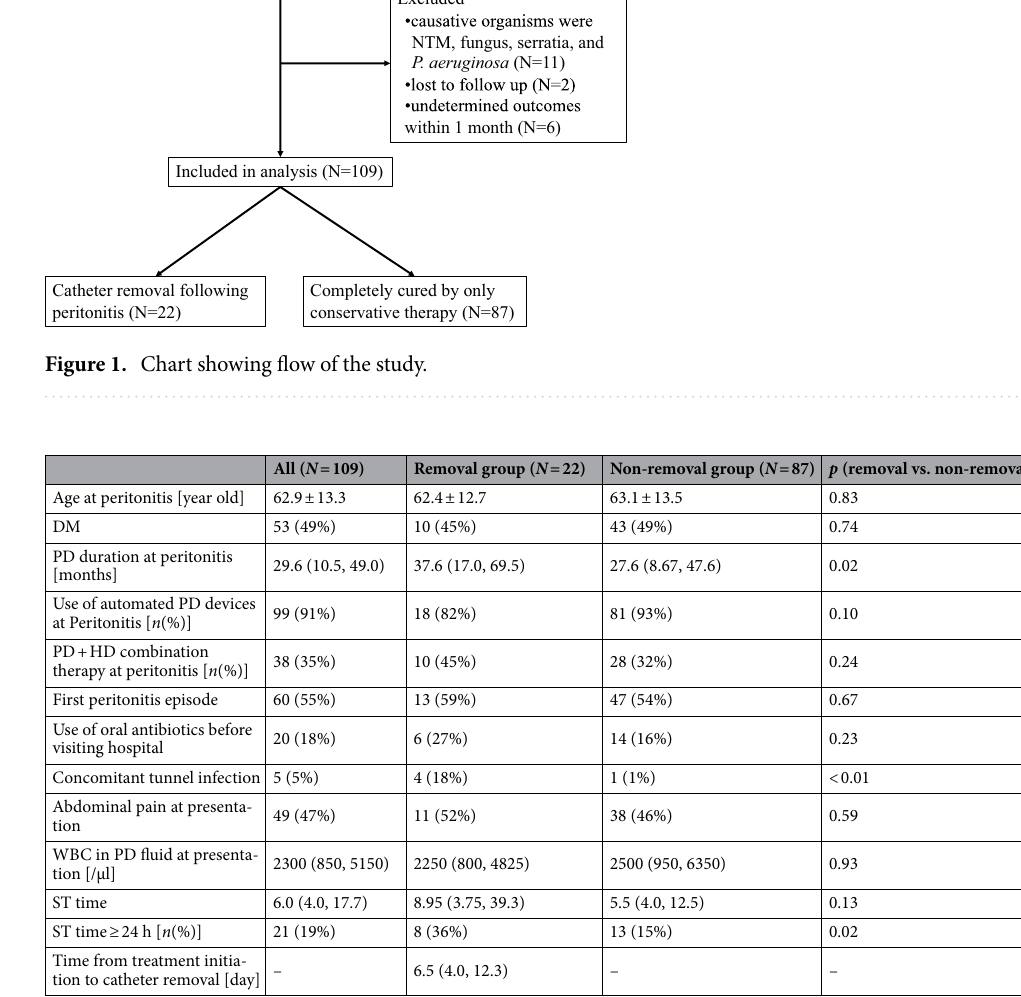
Table 1. Comparison between removal and non-removal groups. Continuous data are presented as median (IQR): DM diabetes mellitus, PD peritoneal dialysis, HD hemodialysis, WBC white blood cell, ST time, required time from sign to treatment